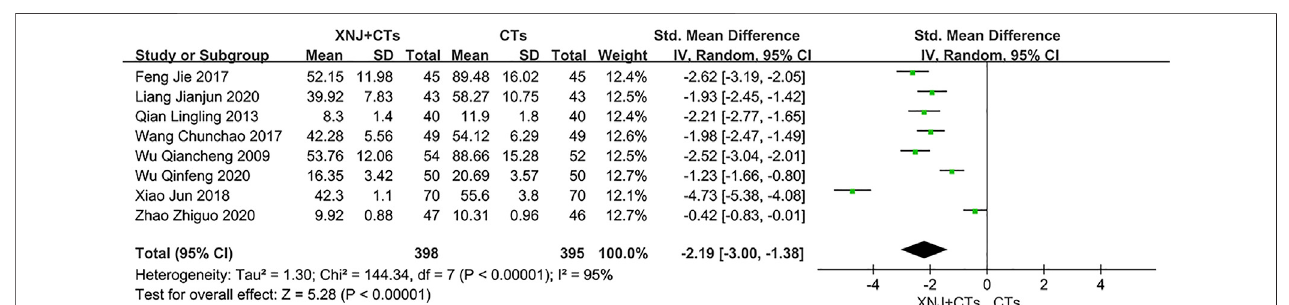
FIGURE 6 | Forest plot of IL-6.